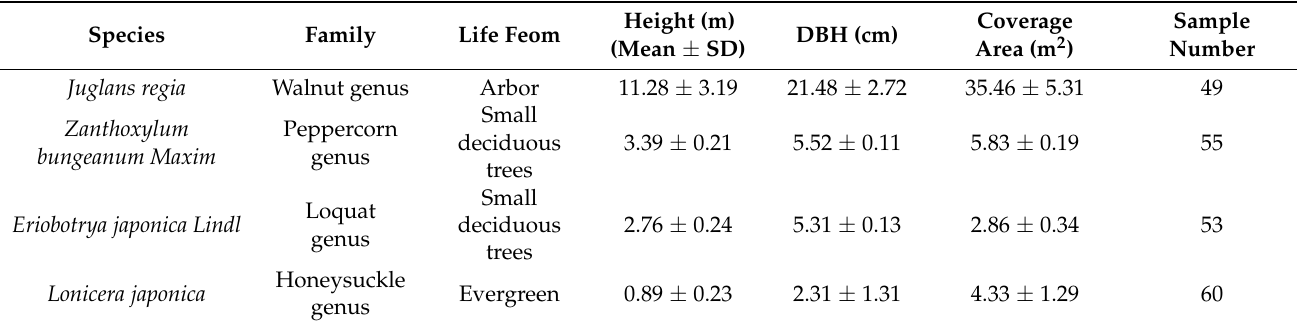
Table 1. Basic information of sampled plant